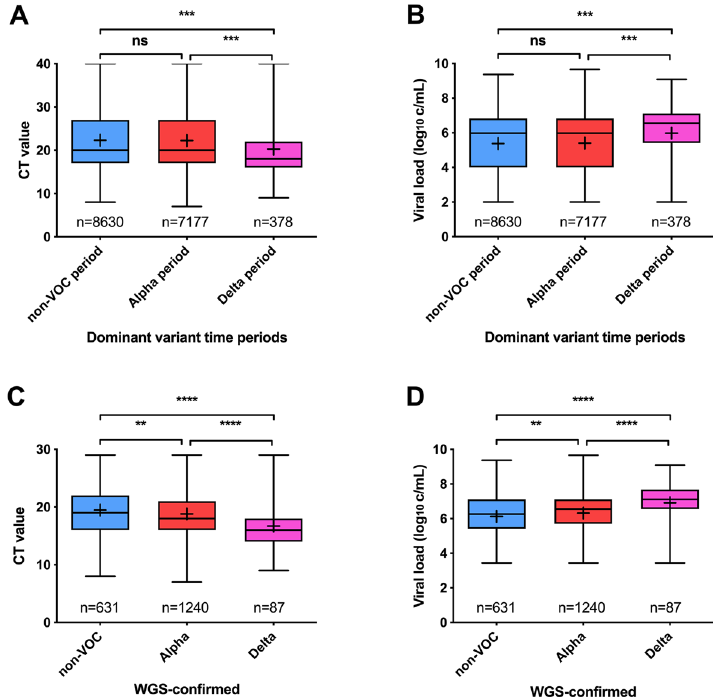
Figure 2. CT values ( A ) and viral loads ( B ) per time period dominated by non-VOC (Dec 2020–Feb 2020), Alpha (Mar 2020–Jun 2020) and Delta (Jul 2020) SARS-CoV-2 variants. CT values ( C ) and viral loads ( D ) per WGS confirmed SARS-CoV-2 variants. Ns not significant, **p < 0.01, ***P < 0.001, ****p < 0.0001. All grouped analyses had a power > 0.99.